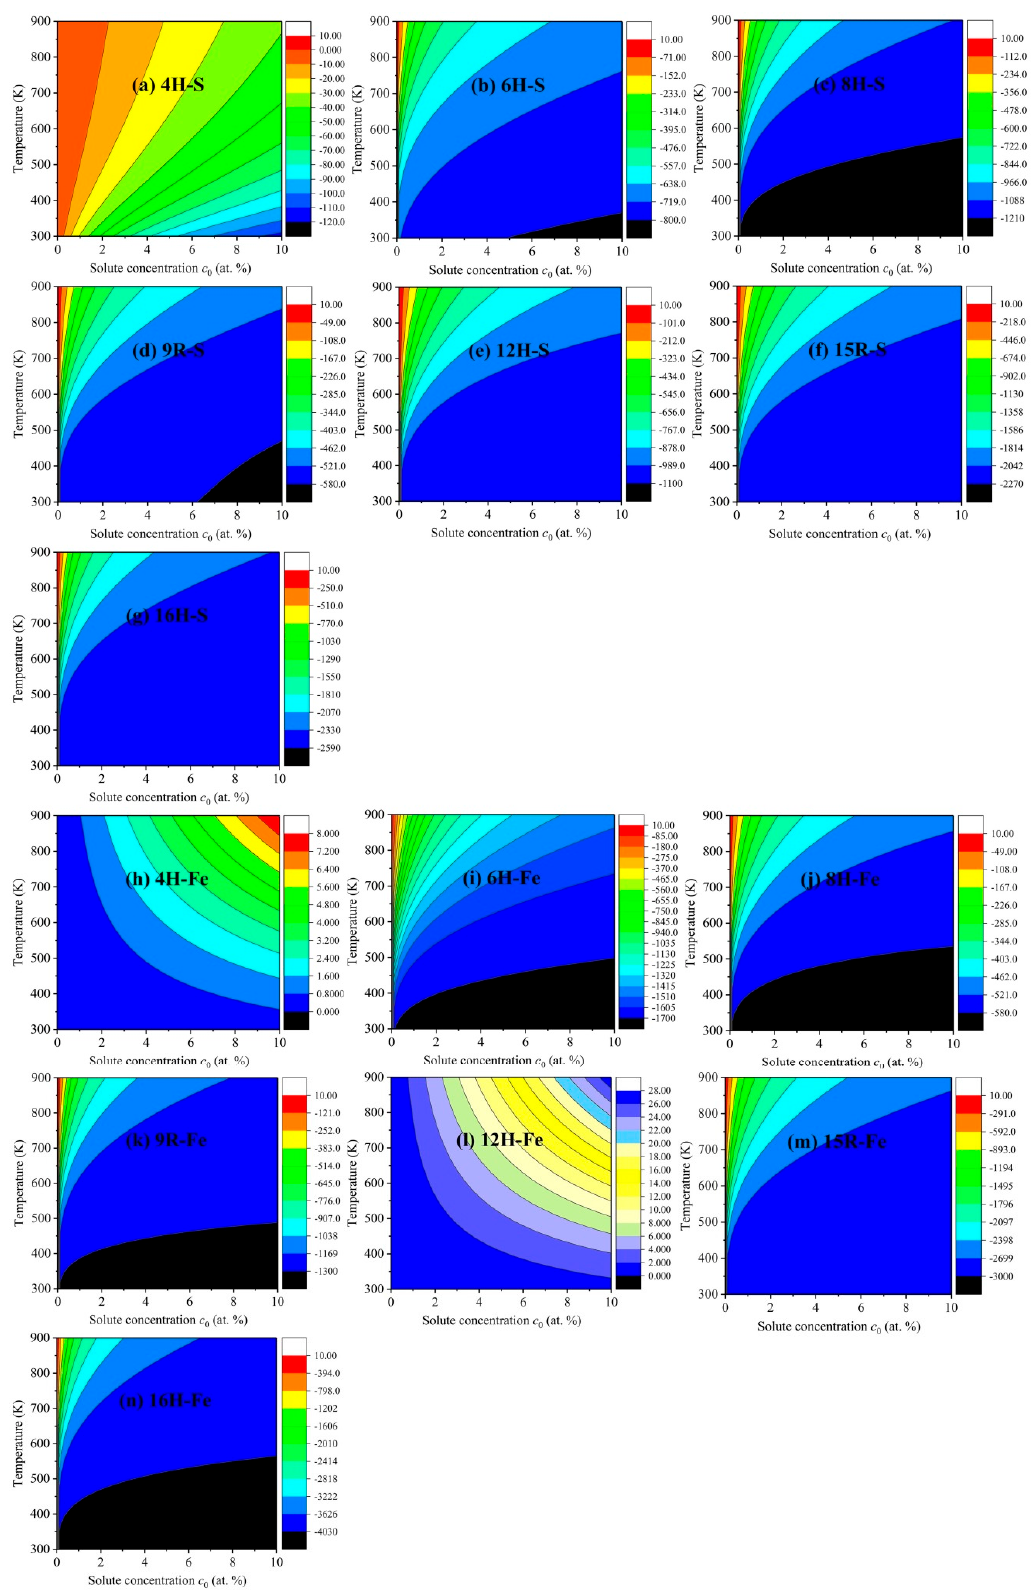
Figure 7. Two-dimensional diagrams of the increments of ISFEs versus solute concentration and temperature in m phases: ( a – g ) denote 4H, 6H, 8H, 9R, 12H, 15R, and 16H phases for the S atom, ( h – n ) indicate 4H, 6H, 8H, 9R, 12H, 15R, and 16H phases for the Fe atom,